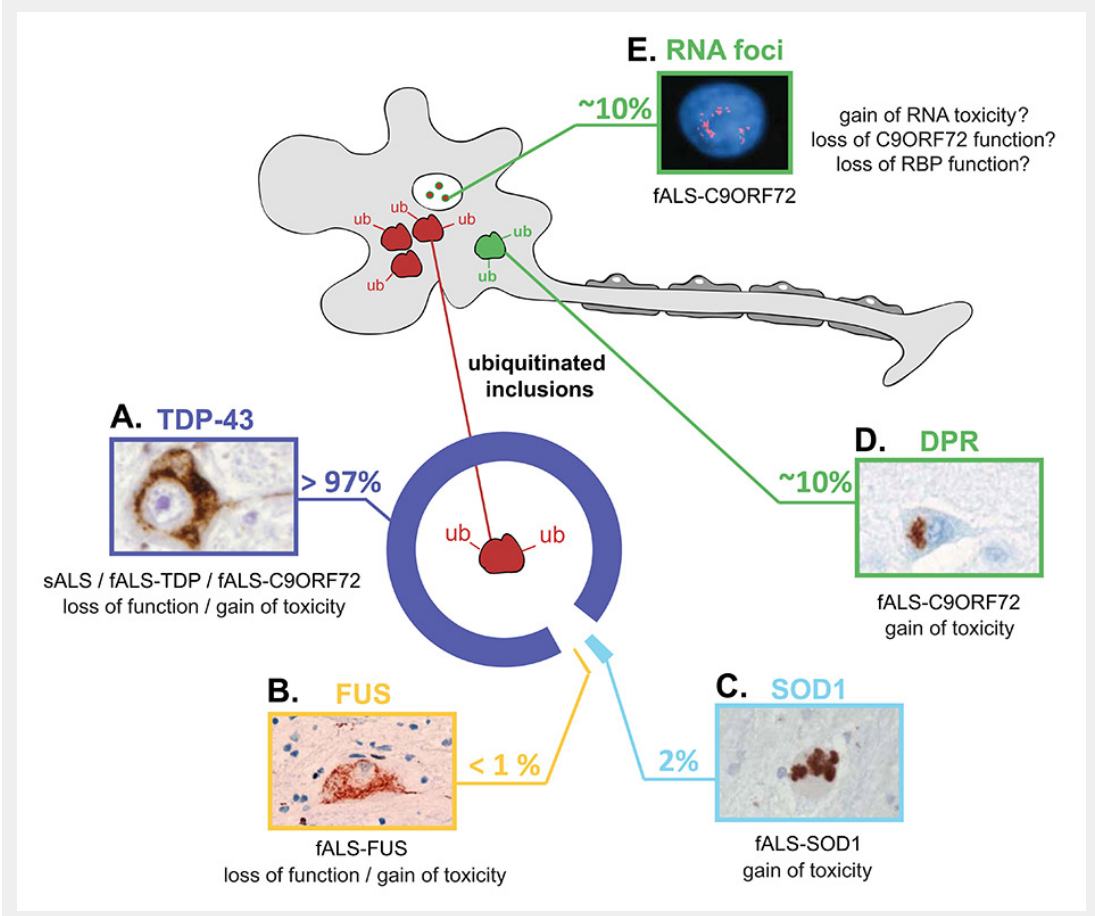
Pathogenic hallmarks of ALS and the underlying factors and mechanisms. The pathologic hallmark of ALS is the presence of ubiquitinated protein inclusions in motor neurons and glial cells primarily of the spinal cord and motor cortex. The major protein component of these inclusions is different in the various types of ALS, highlighting the heterogeneity of the disease. (A) In the majority of ALS cases, including all sporadic and most familial cases, the ubiquitinated inclusions contain TDP-43. When TDP-43 accumulates in the cytoplasm, it is excluded from the nucleus, where it normally resides in healthy cells. These alterations suggest that either loss of normal TDP-43 function or gain of toxicity (or both) may trigger motor neuron dysfunction and death. (B) In 0.5% of fALS that carry mutations in FUS , the cytoplasmic inclusions do not contain TDP-43, but they contain FUS protein. Similar observations to that of TDP-43, with partial nuclear clearance of FUS suggest that its neurotoxity may be the result of either loss of function or gain of toxicity. (C) In fALS patients with SOD1 mutations, misfolded SOD1 accumulates and becomes toxic to neurons. These patients do not contain any TDP-43 or FUS inclusions. (D) In contrast, patients with hexanucleotide repeat expansions in C9ORF72 show typical TDP-43, similar to those found in sALS (A). In addition, C9ORF72 patients accumulate abnormal dipeptide repeat (DPR) proteins, which are produced by an unconventional type of translation of the hexanucleotide repeat RNA, which escapes the nucleus, and binds to ribosomal complexes. In addition to spinal cord motor neurons, DPRs have been observed in the cerebellum, which is typically spared in non-C9ORF72 ALS. (E) In addition to TDP-43 and DPR pathology, C9ORF72 patients accumulate nuclear RNA foci that contain sense and antisense hexanucleotide repeats in neuronal and glial cells. Insert images reproduced with permission from (A) [54], (B) [60], (C) [35], (D) [39], (E)